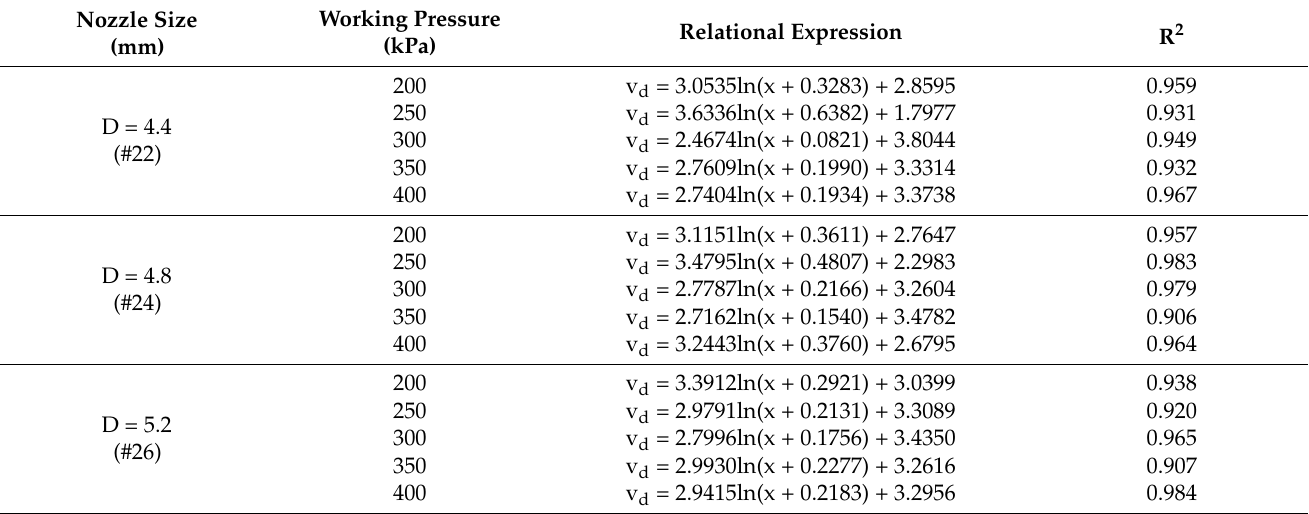
Table 1. Logarithmic relationships between droplet mean velocity and diameter under different working pressures and their R 2